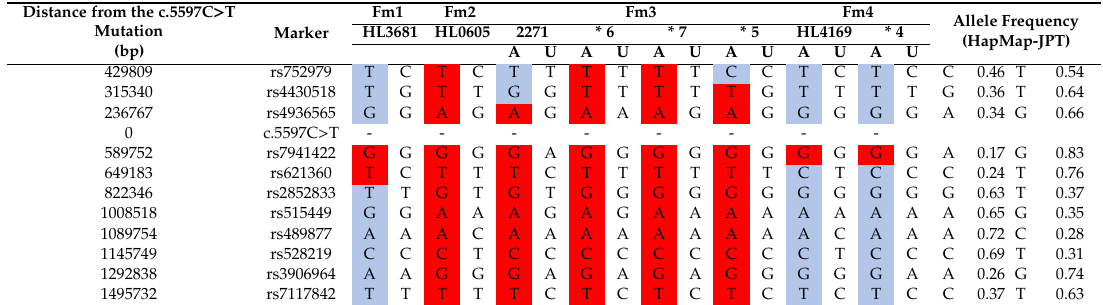
Table 3. The haplotypes around the TECTA : c.5597C > T mutation identified from four families. Distance from the c.5597C > T